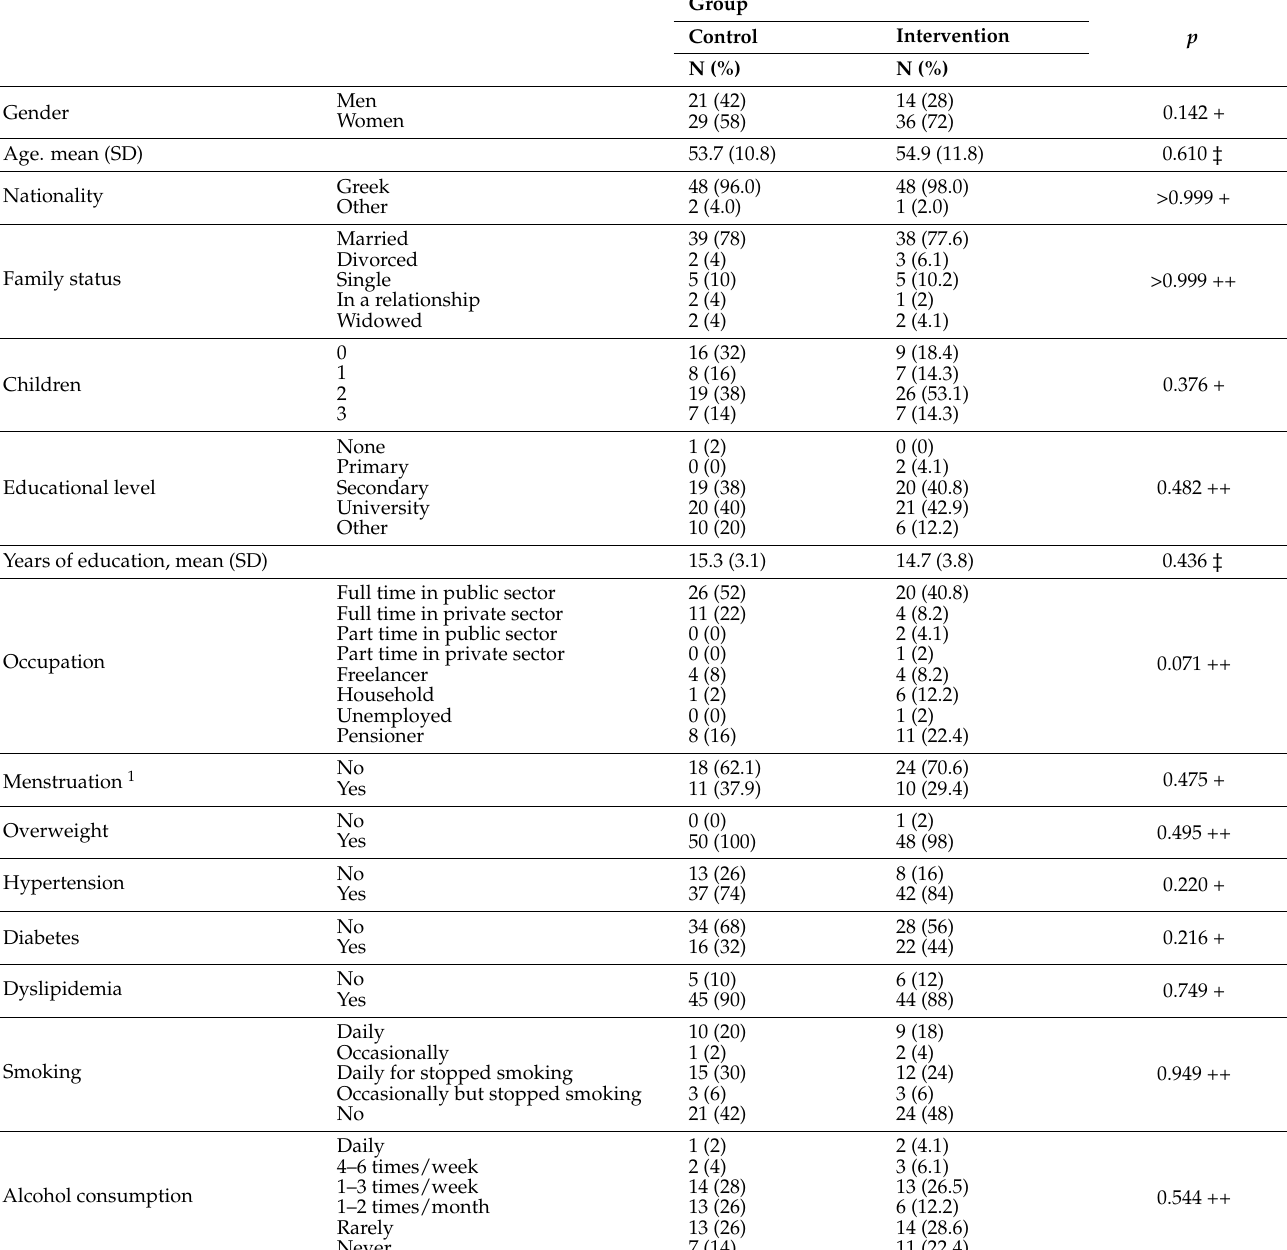
Table 2. Demographics in control and intervention groups. The results are given as N (%) of the total